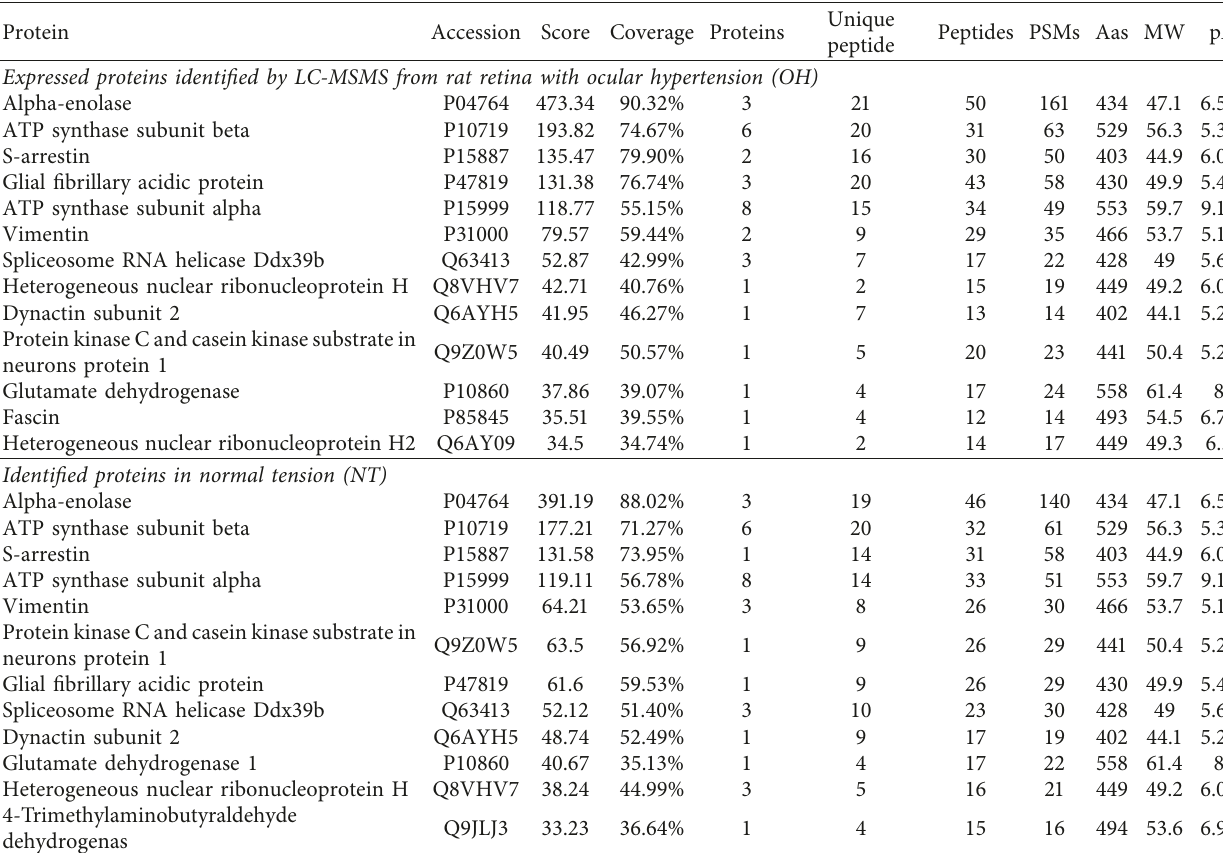
Table 1: Identification of